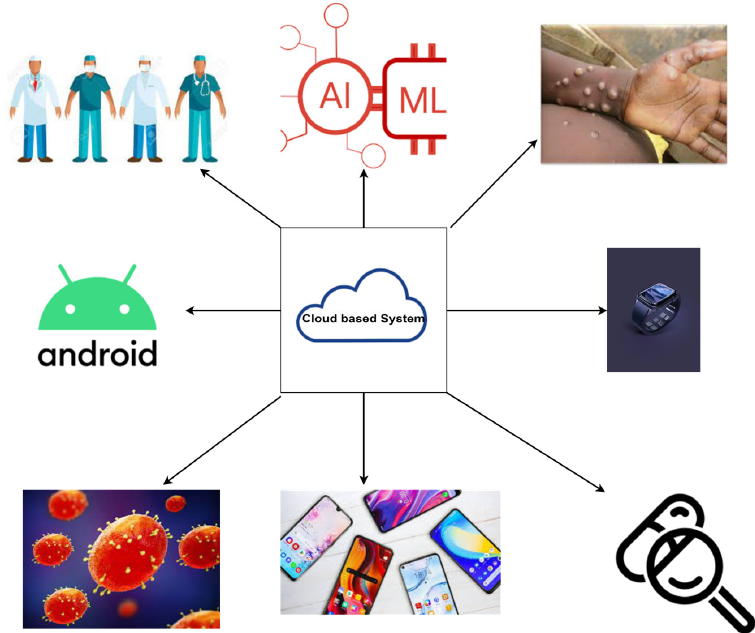
Figure 8. Cloud ‐ based system for mpox management. Figure 8. Cloud-based system for mpox